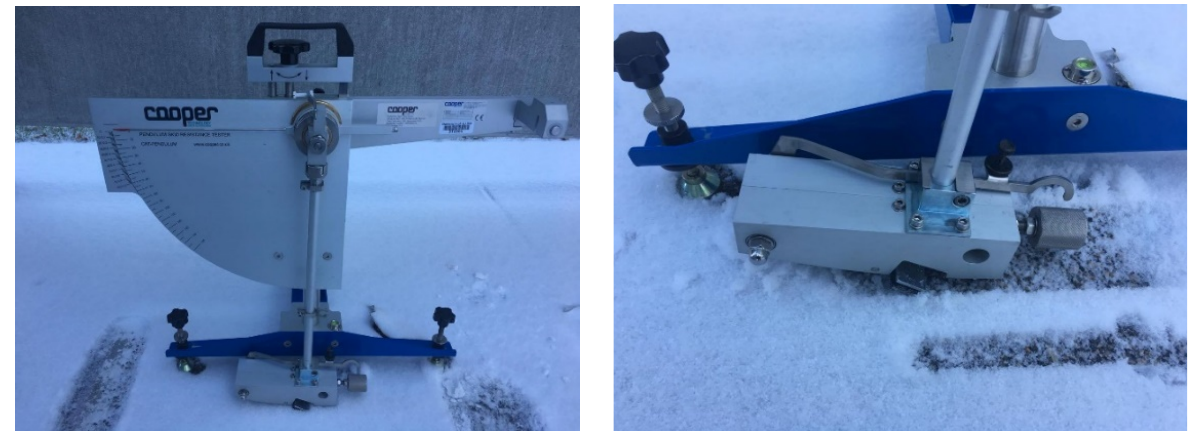
Figure 4. BPT tester for testing sealcoats under snow conditions. Table 1. t -Test: paired two sample for means.